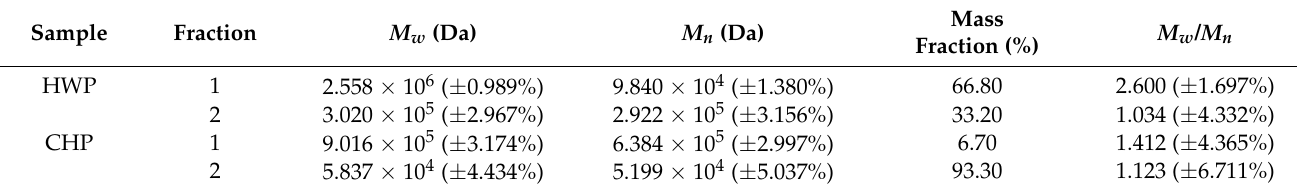
Table 4. Molecular characteristics of HWP and